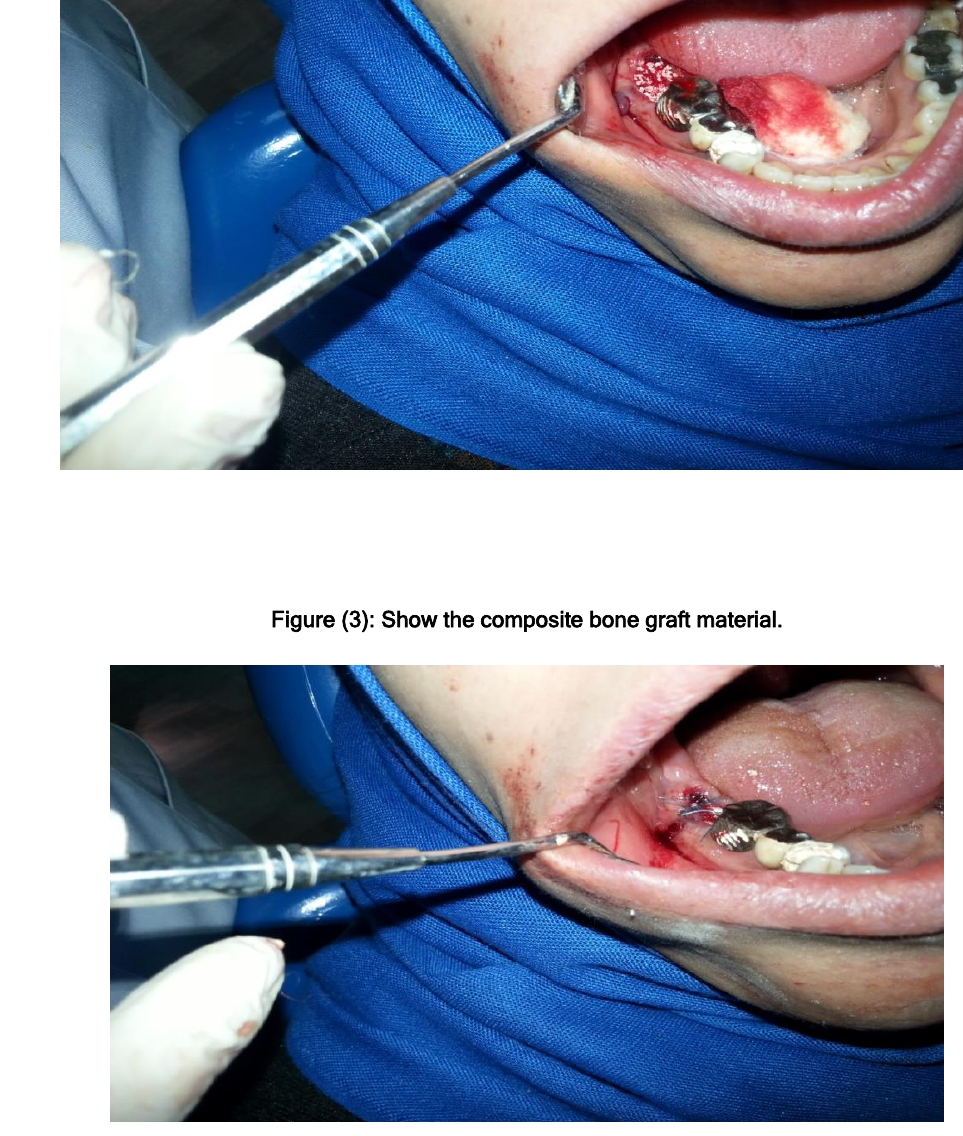
Figure (4): The area after complete treatment and Suturing with resorbable suture.